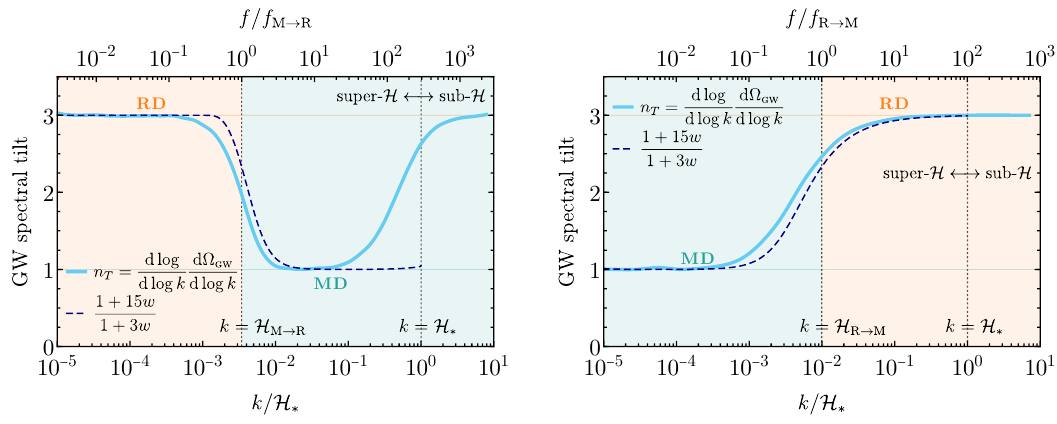
Figure 7 . A comparison between the exact equation of state of the universe versus what is measured from the slope of the GW spectrum. In the solid blue line, we have the exact numerical result while in the dashed blue line, we have the approximation as measured from the slope of the GW